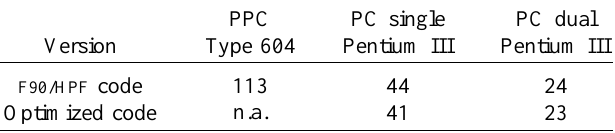
TABLE II. CPU time in seconds for the reconstruction with space charge of one well-resolved image using different proces- sors and different versions of the sine function. A fast FORTRAN library for the sine function was used on the